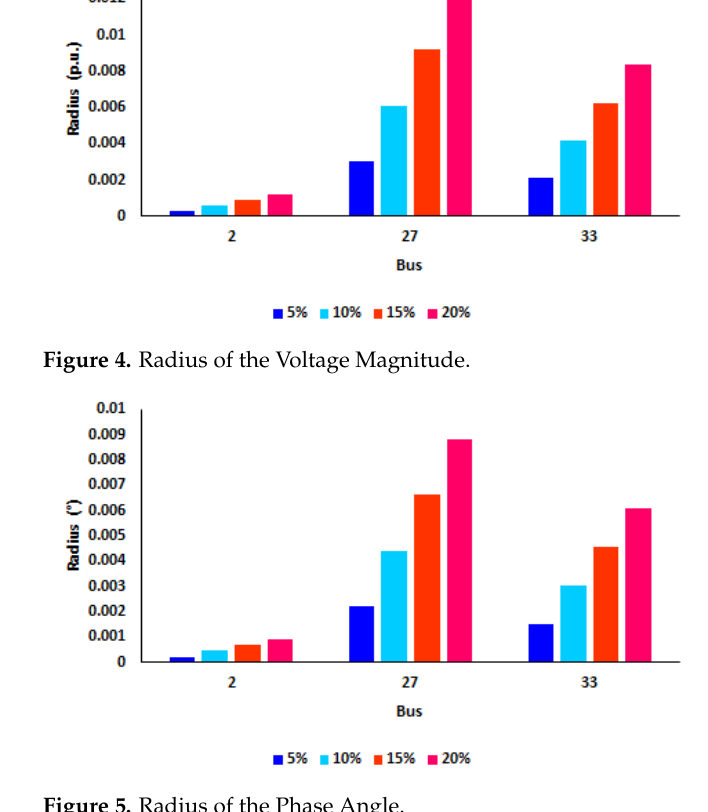
Figure 5. Radius of the Phase